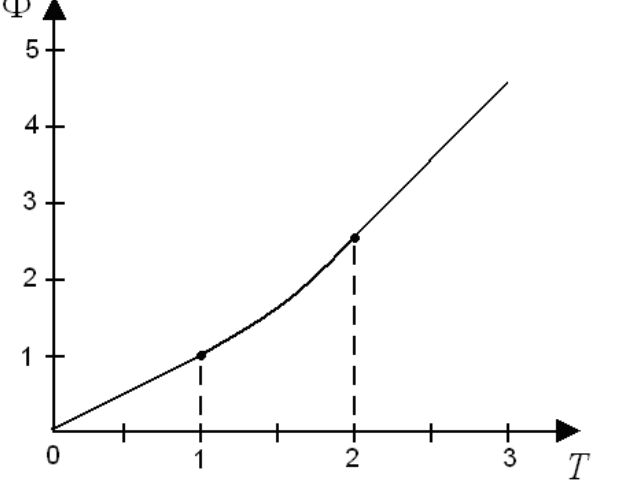
Figure 2. Φ as a function of T for a case in which a = 1, b = 2, and k = ˆ k ( T ) = T for T ∈ [ 1,2 ] Φ Figure 2. as a function of T for a case in which T [ ] 1, 2 T ∈ .